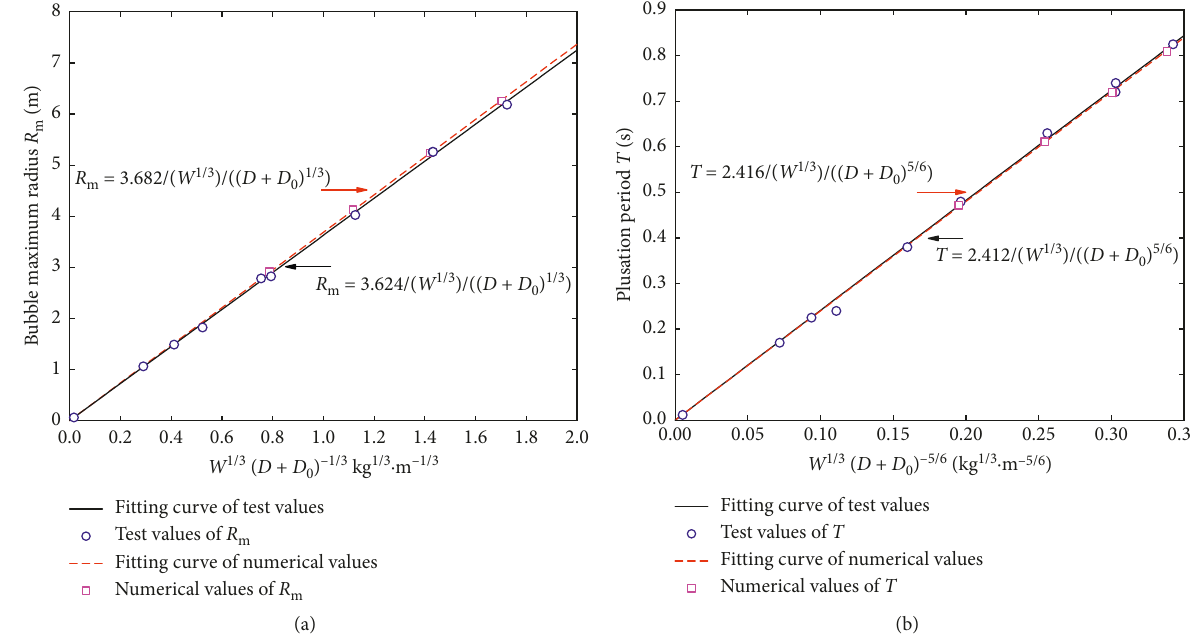
Figure 21: Characteristics of bubble pulsation in prototype conditions: (a) R